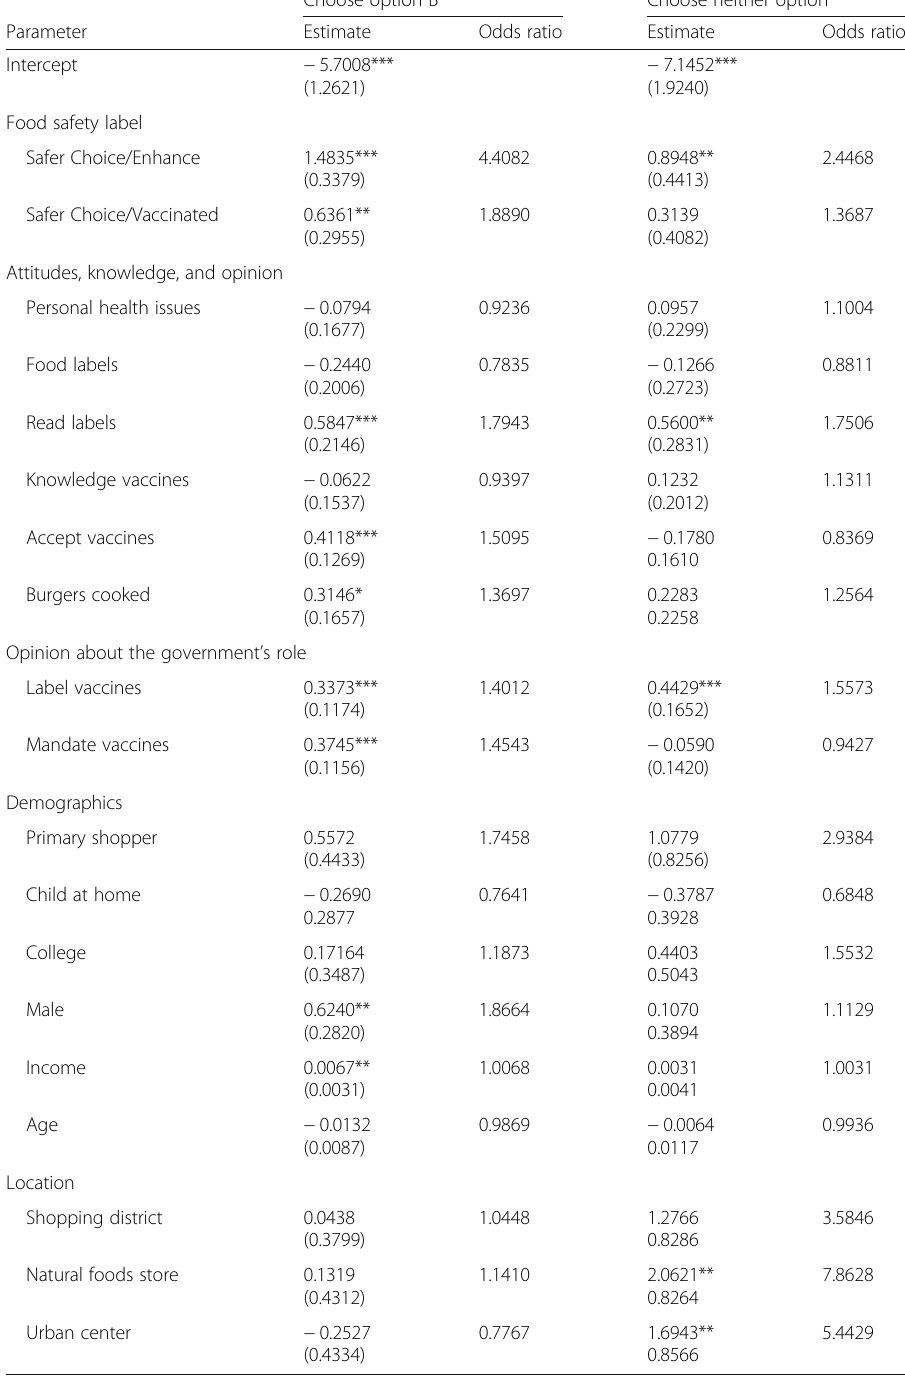
Table 5 Multinomial logit results for the labeling choices Choose option B Choose neither option Parameter Estimate Odds